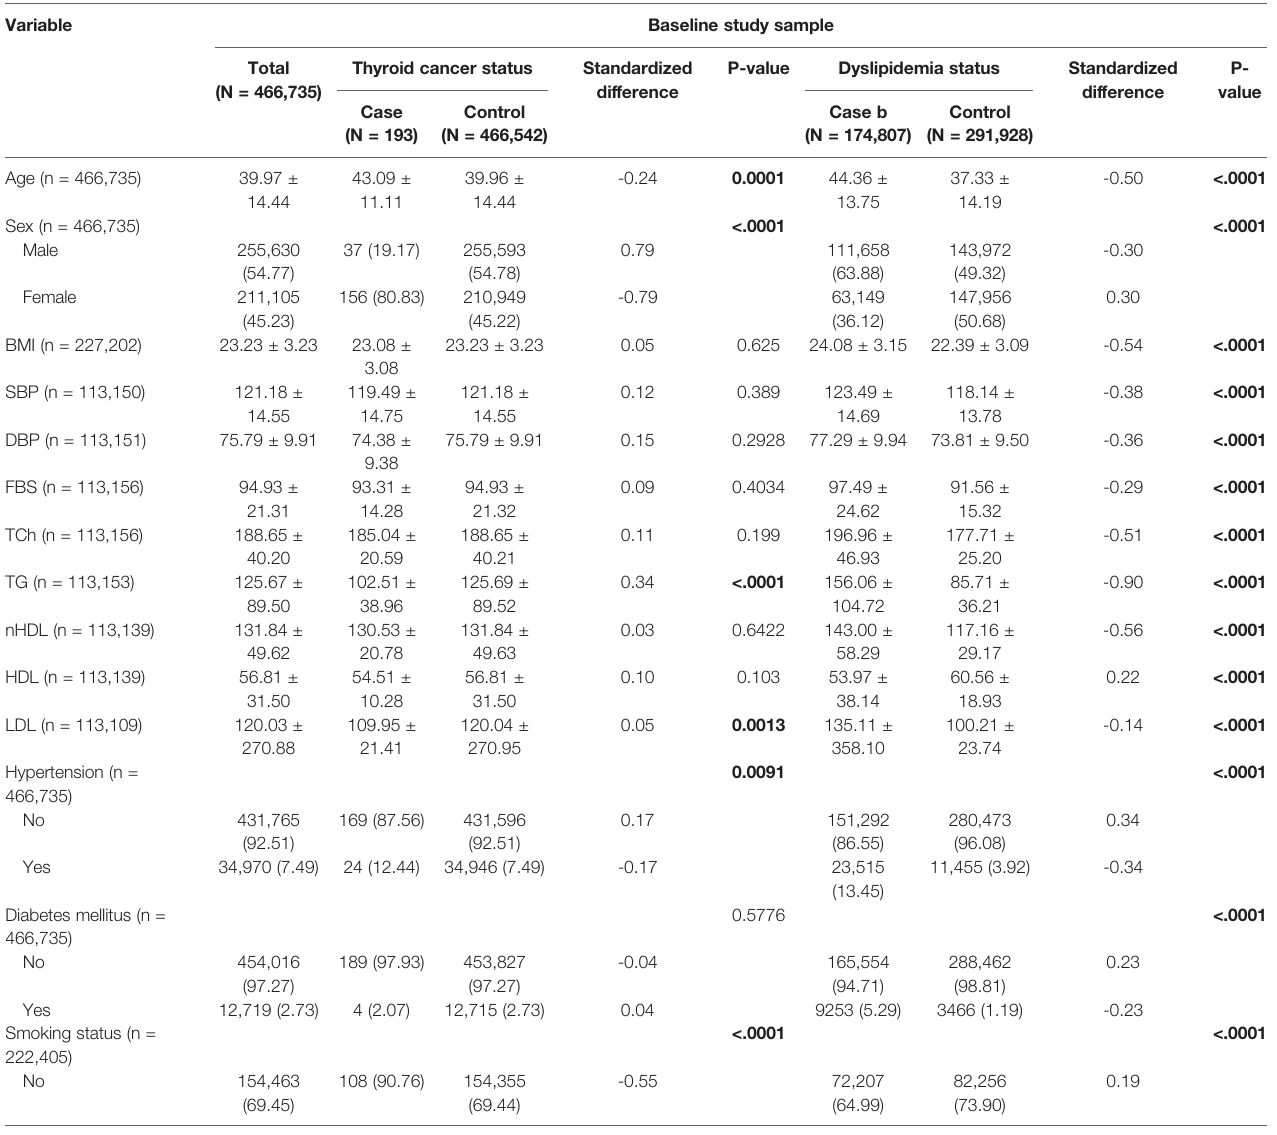
TABLE 1 | Baseline characteristics of the general study population according to the thyroid cancer and dyslipidemia statuses. Variable Baseline study